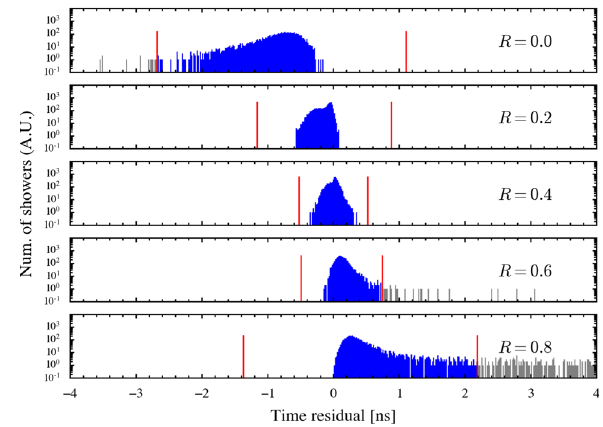
Fig. 8 The distribution of the difference between reconstructed shower time and the true time in the 10 GeV π + sample. To remove the outliers, a time residual window (red lines) is defined as [